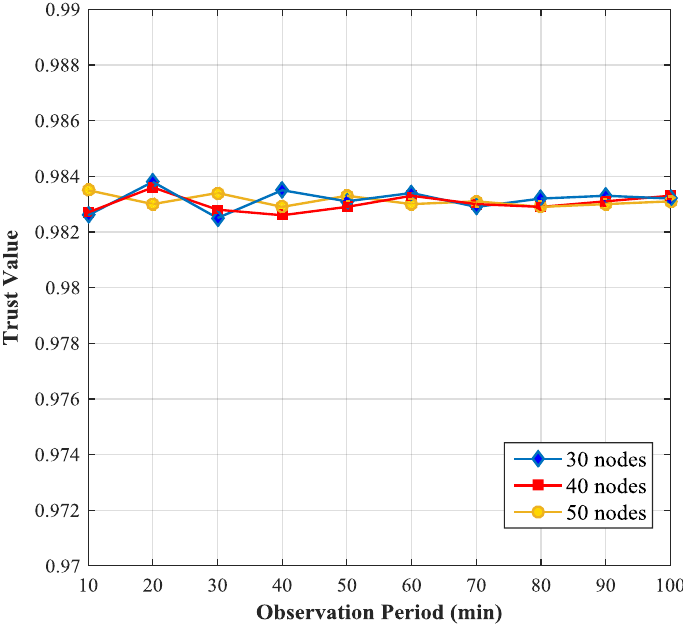
Figure 3. Sensitivity of trust value to simulation time and node density .